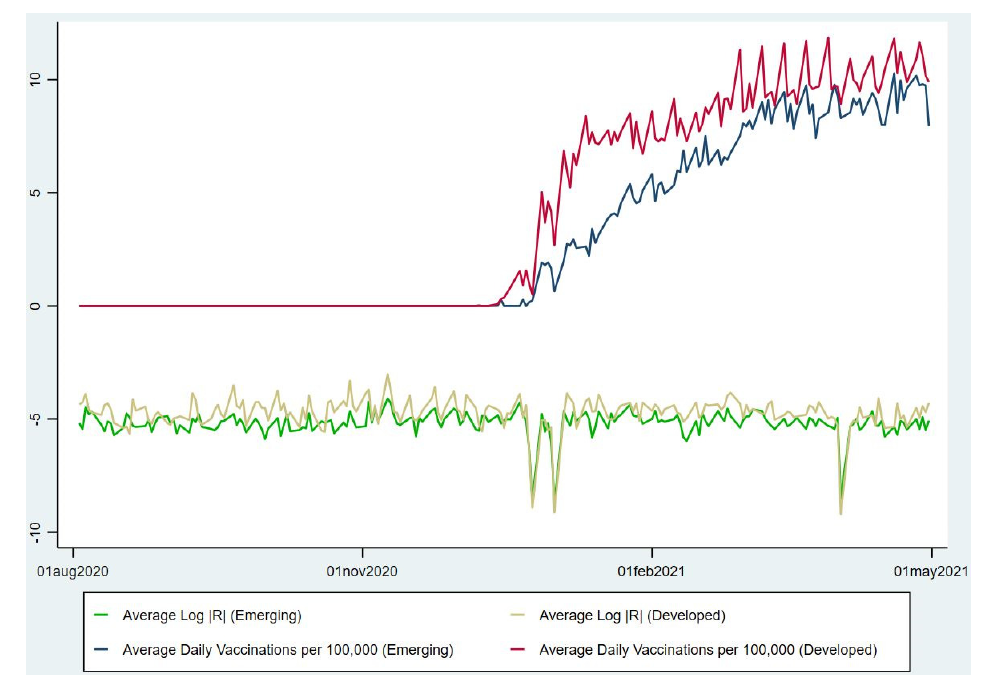
Figure 1. Vaccination and stock market volatility in developed and emerging markets. Daily averages are computed across the sample countries. Table 7. Vaccinations and volatility: developed vs. emerging markets.